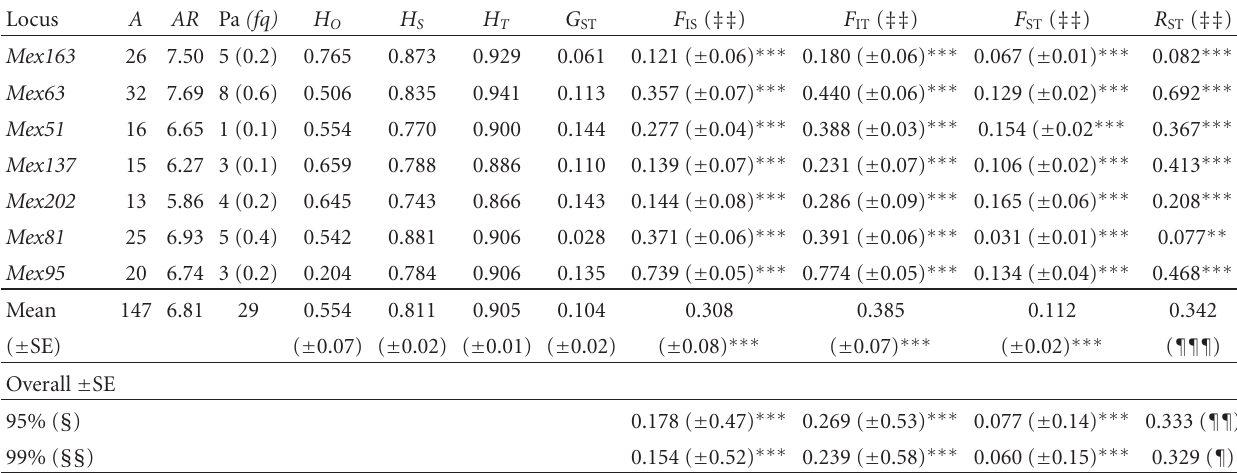
Table 2: Estimates of single locus heterozygosity and genetic di ff erentiation of the twelve Milicia excelsa populations over seven microsatellite